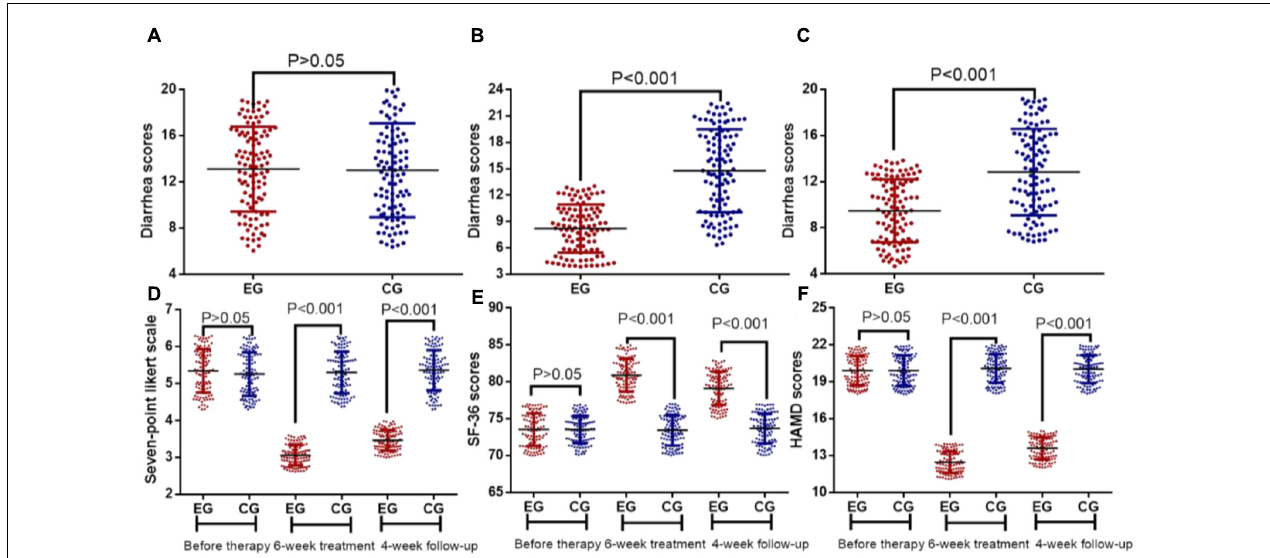
FIGURE 3 | Therapeutic effects of Extracts of Fructus mume (EFM) on breast cancer patients with diarrhea. (A) diarrhea scores before therapy. (B) Diarrhea scores after 6-week therapy. (C) Diarrhea scores after 4-week follow-up. (D) The effects of EFM on gastrointestinal symptoms. (E) The effects of EFM on SF-36 scores. (F) The effects of EFM on HADS scores. EG, the patients received EFM treatment. CG, the patients received placebo treatment. n = 104 for each group.